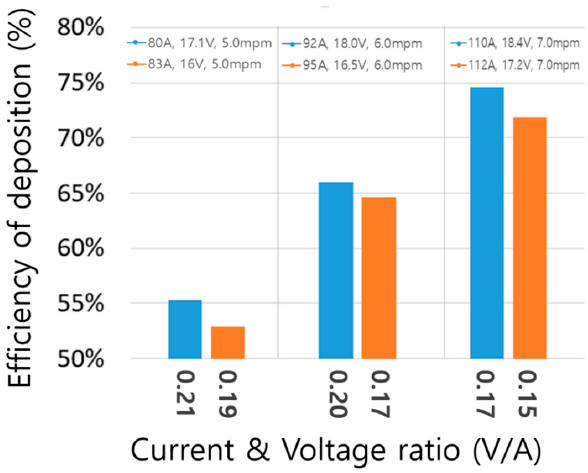
Figure 11. Variation of efficiency of deposition according to the current and voltage ratio. Processes 2020 , 8 , x FOR PEER REVIEW